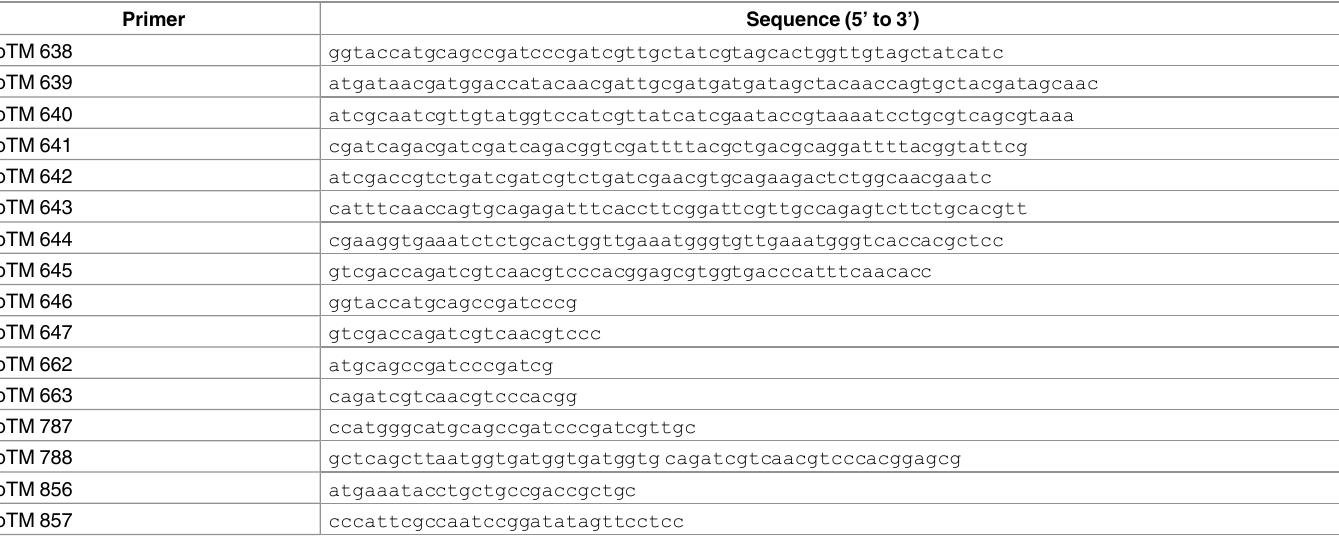
Table 2. Oligonucleotide used in this work.